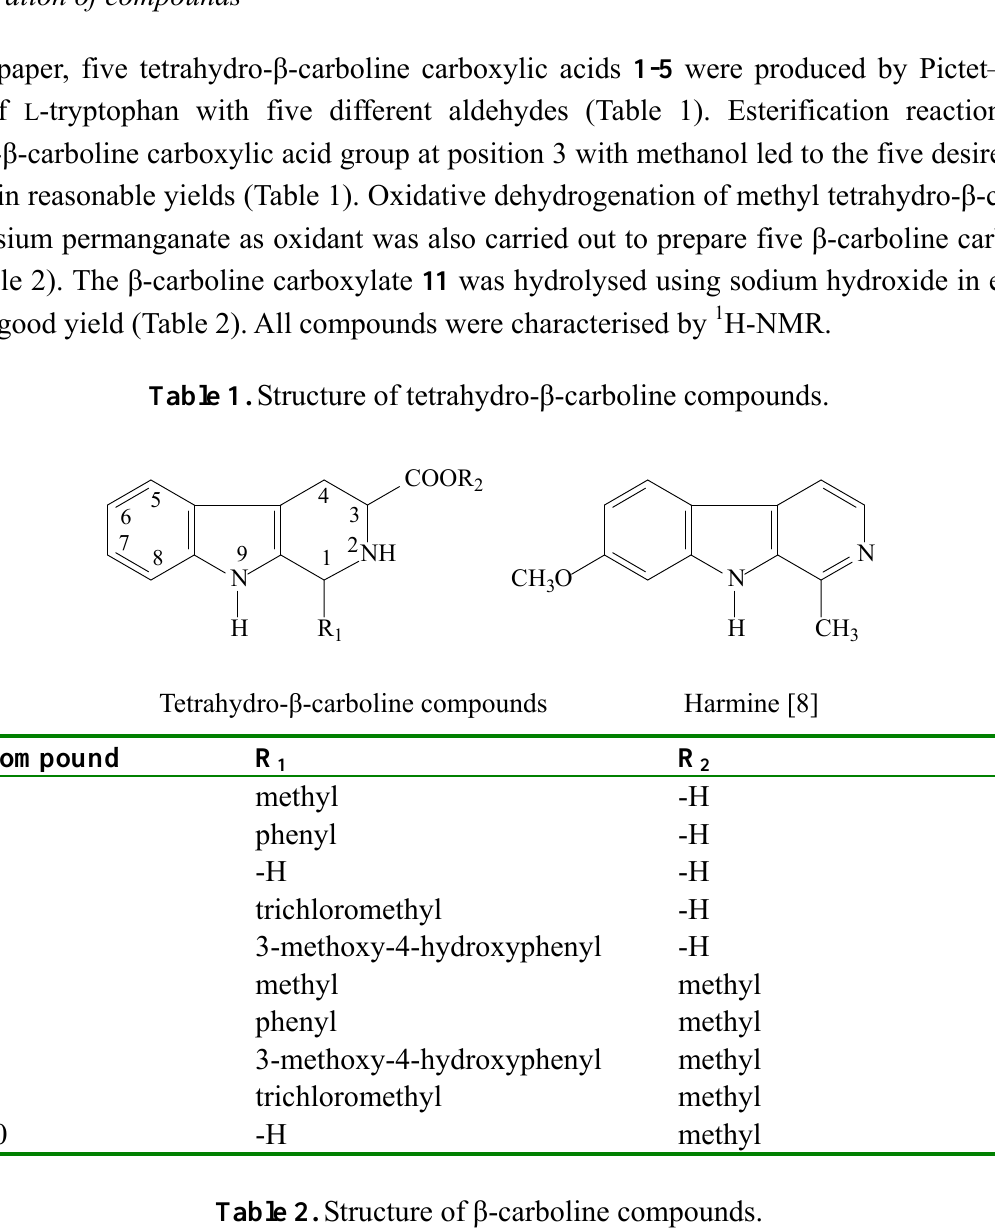
Table 2. Structure of β -carboline